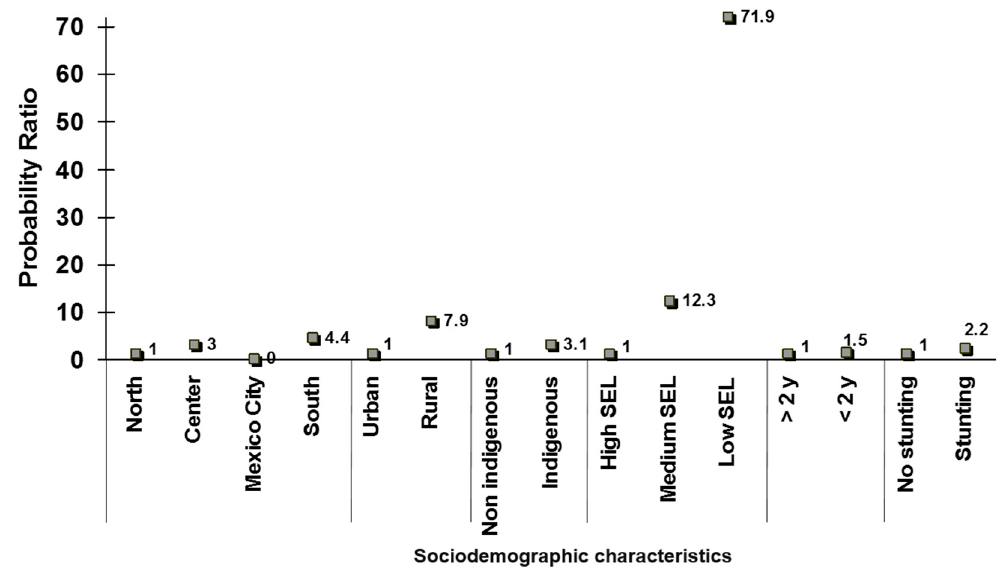
Figure 4. Probability rate ( ± 95% C.I.) of participation in Food programs in households with children <5 years of age in 1999. Adapted from a published source [9], N = 8011 children <5 years, National Nutrition Survey 1999, Stunting or no stunting in the household.